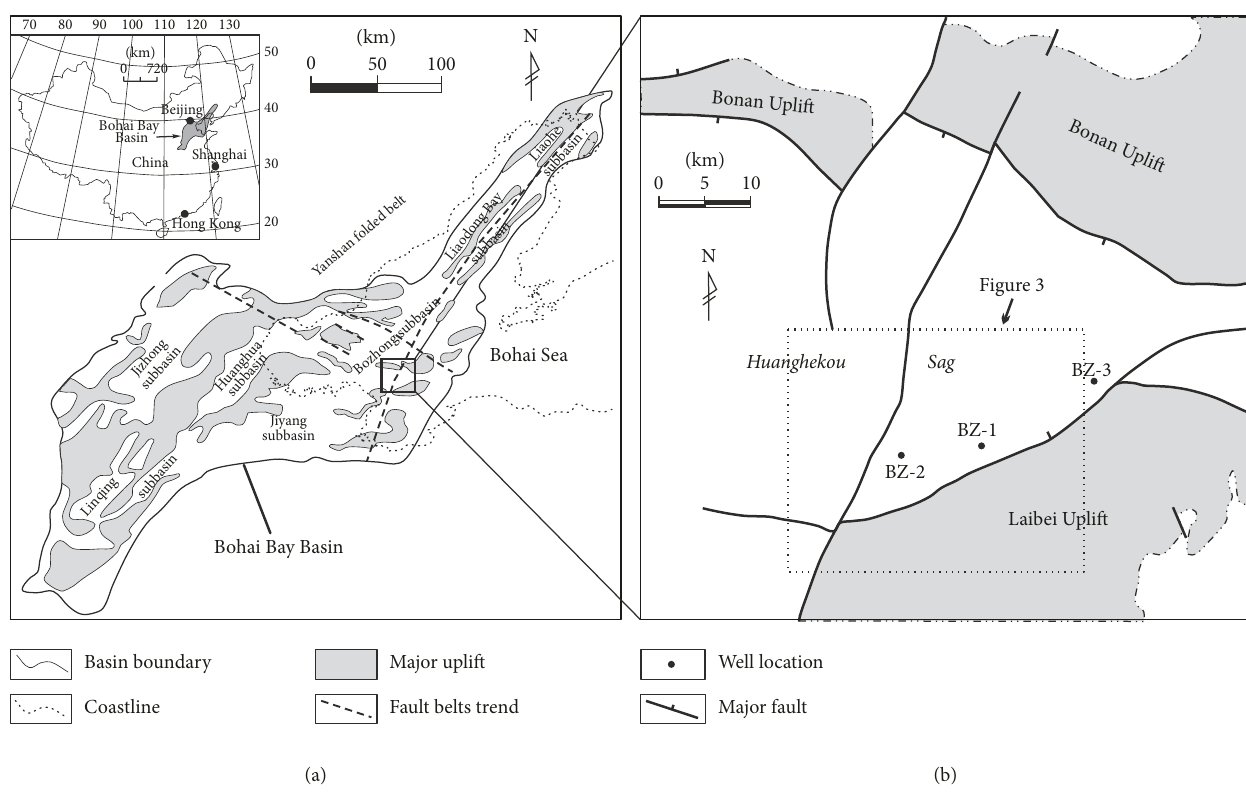
Figure 1: (a) Location map of subbasins of the Bohai Bay Basin, eastern China (modified from [8]). (b) Map of the Huanghekou Sag showing the distribution of major faults and